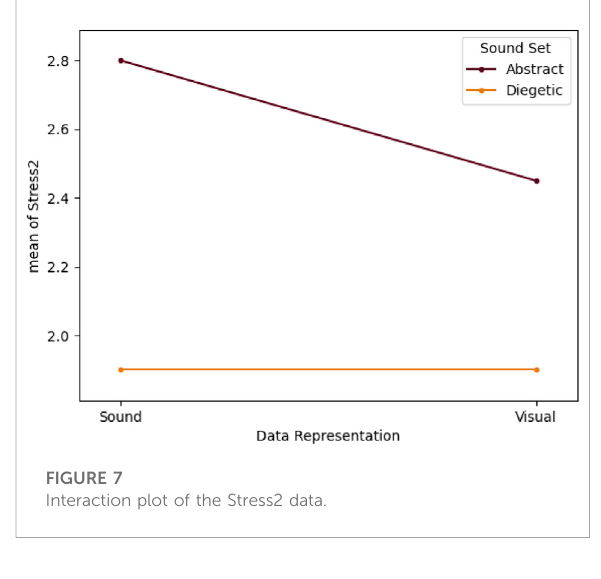
FIGURE 7 Interaction plot of the Stress2 data.